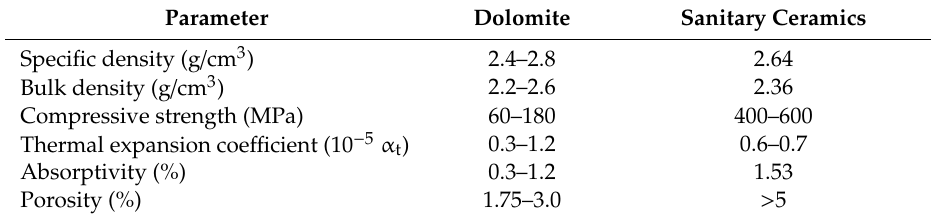
Table 1. Technical parameters of aggregates used in the analysis based on [47].